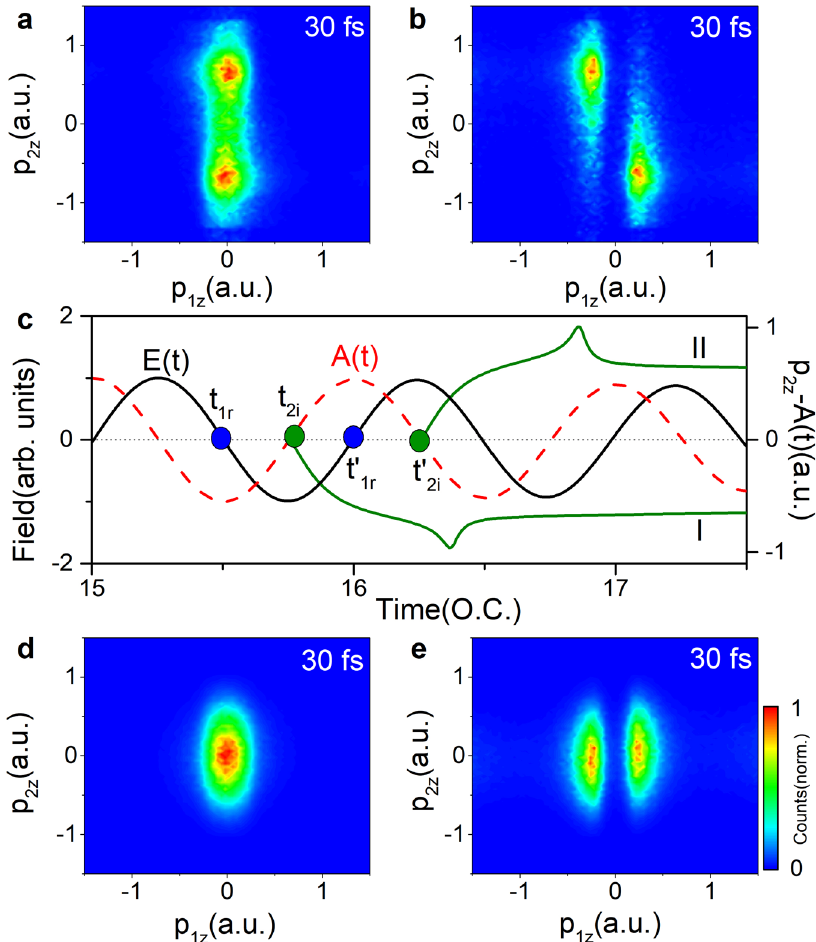
Fig. 5 Effect of Coulomb fi eld of Ar 2 + on correlated electron momentum distributions (CEMDs). a , b CEMDs without performing electron indistinguishability symmetrization, and only recolliding trajectories of e 2 with ionization time nearest the collision time of e 1 are included. c Schematic representation of the laser electric fi eld E ( t ) and the corresponding vector potential A ( t ) for pulse duration of 30 fs. e 1 collides with the ion most probably at the crossing of E ( t ) at t 1 r or t 0 . Upon the collision, e 2 is excited, and then is ionized most probably at the peak of the laser fi eld at t 2 i or t 0 . The subsequent 1 r 2 i evolution of the canonical momentum p 2 z – A ( t ) for the recolliding trajectories of e 2 , denoted as I and II, are presented to illustrate the Coulomb- fi eld effect of Ar 2 + . d , e CEMDs calculated by replacing the ionization amplitude M ð 3 Þ ~ in Eq. 1 with the standard SFA. Trajectories of e 1 are con fi ned to the fi rst return in P 2 a , d , and the third return in b , e . Each CEMD is normalized to itself. The carrier-envelope phases are